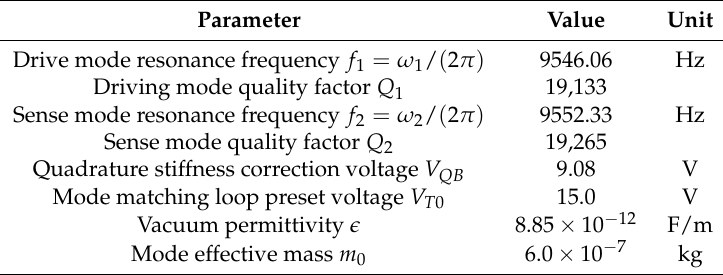
Table 2. The main parameters of the DRG in the simulation